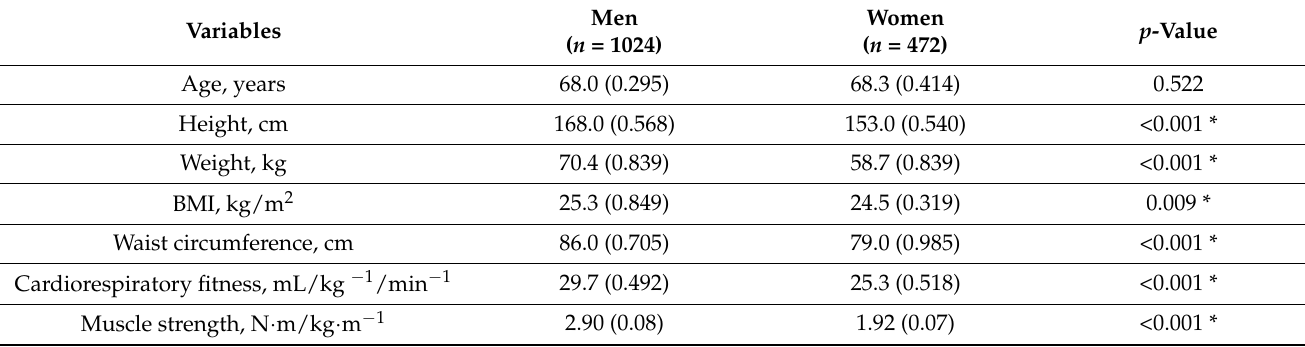
Table 1. General characteristics of